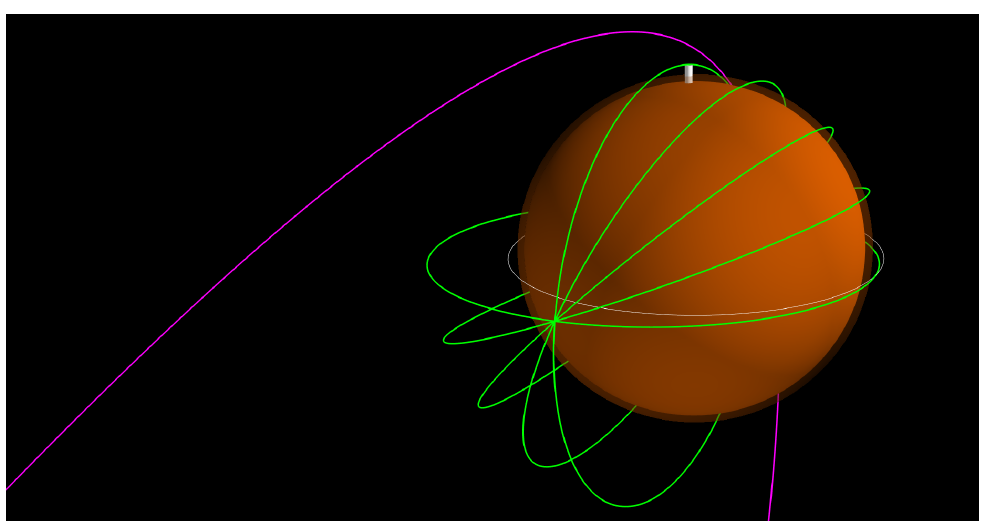
Figure 28. Mars small satellite constellation in 200 × 2000 km orbits with various inclinations from equatorial to polar (green), and the host orbiter in 250 × 70,000 km polar orbit.